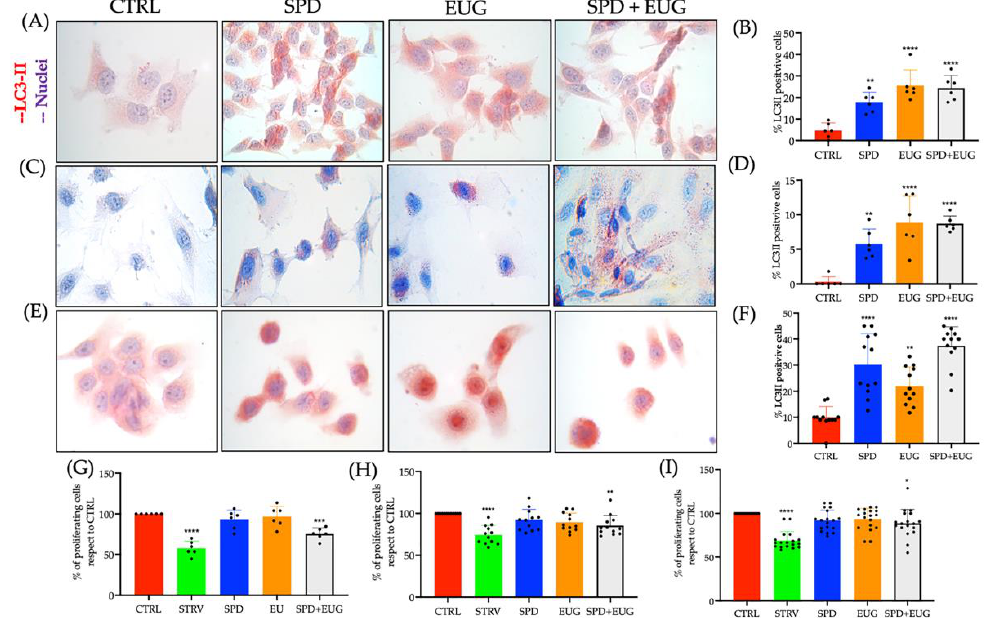
Figure 3. The effect of 0.3 mM spermidine (SPD) and 0.2 mM eugenol (EUG), alone or in combination (0.3 mM SP + 0.2 mM EUG) on LC3-II activation in SHSY5Y ( A , B ), HUVEC ( C , D ) and HBEpiC ( E , F ) cell lines after 4 h. LC3-II was detected by fast red chromogen staining ( A , C , E ) and the percentage of LC3-II positive cells reported compared to untreated control cells ( B , D , F ). The MTT assay for all treatments was performed and the data reported as percentage of the untreated control for ( G ) SHSY5Y ( H ), HUVEC and ( I ) HBEpiC cells. The number of stars *, **, *** and **** represents